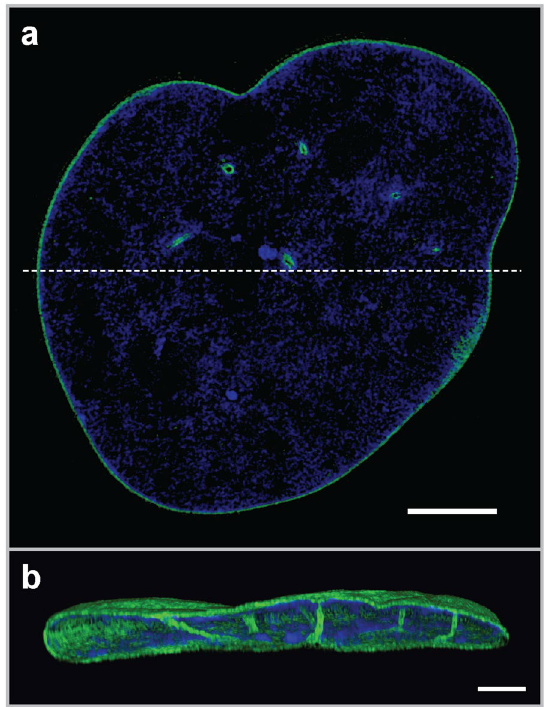
Figure 1. Nucleoplasmic Reticulum (NR) in normal Human Dermal Fibroblasts (HDFs). Super resolution light microscopy on untreated normal HDFs showing distribution of Lamin B1 (Green; anti-lamin B1 immunostaining) and chromatin (Blue: Di-amino-phenyl-indole; DAPI). ( a ) Nuclear mid-section showing intranuclear lamin B1 foci surrounding NR channels. ( b ) 3D reconstruction of nucleus with vertical cross- section (along dashed line shown in a) showing NR channels traversing the nucleus. Scale bar 2 µ